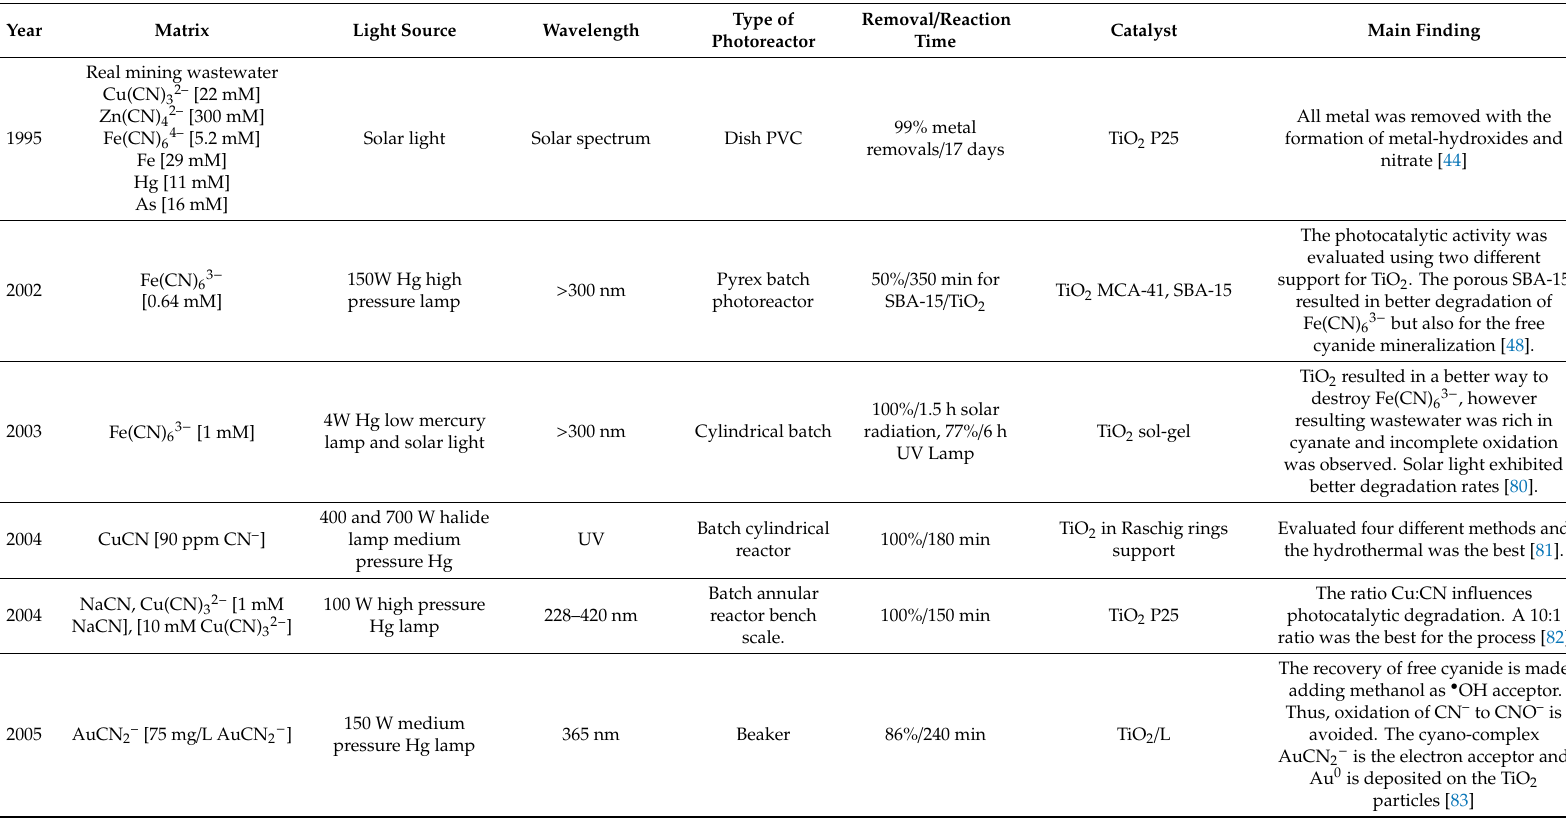
Table 3. Photocatalytic treatments of metallic